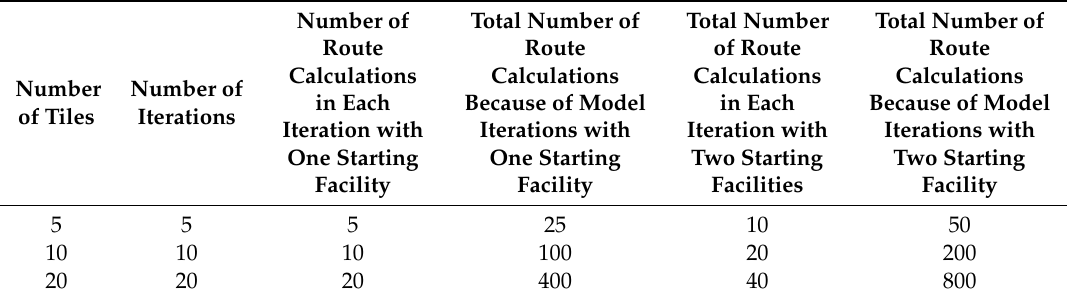
Table 1. Impact of the number of tiles and facilities on the number of iterations and route